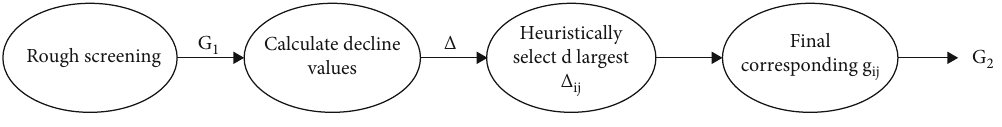
Figure 1: Architecture of two-stage screening